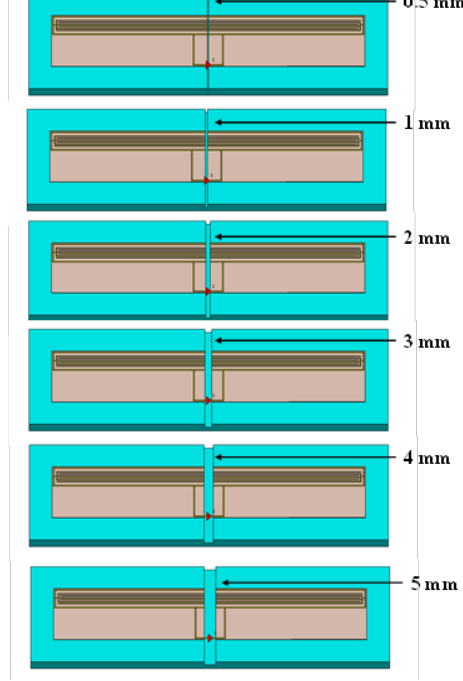
Figure 8. The size of the crack widths experimented. Table 3. Simulated input parameters for Vertical Crack Orientation (first two